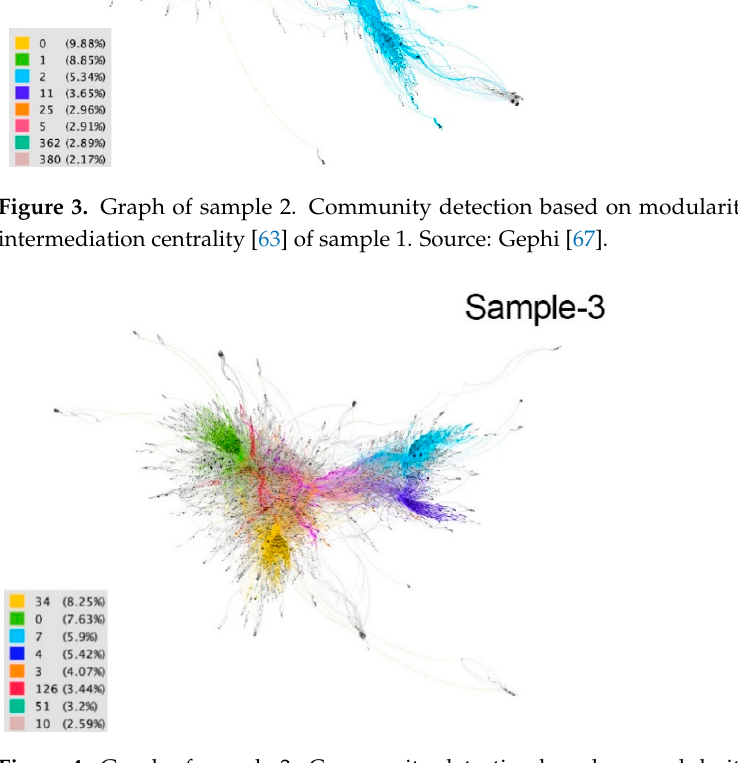
Figure 5. Graph of sample 4. Community detection based on modularity [66] and according to in- termediation centrality [63] of sample 1. Source: Gephi [67].